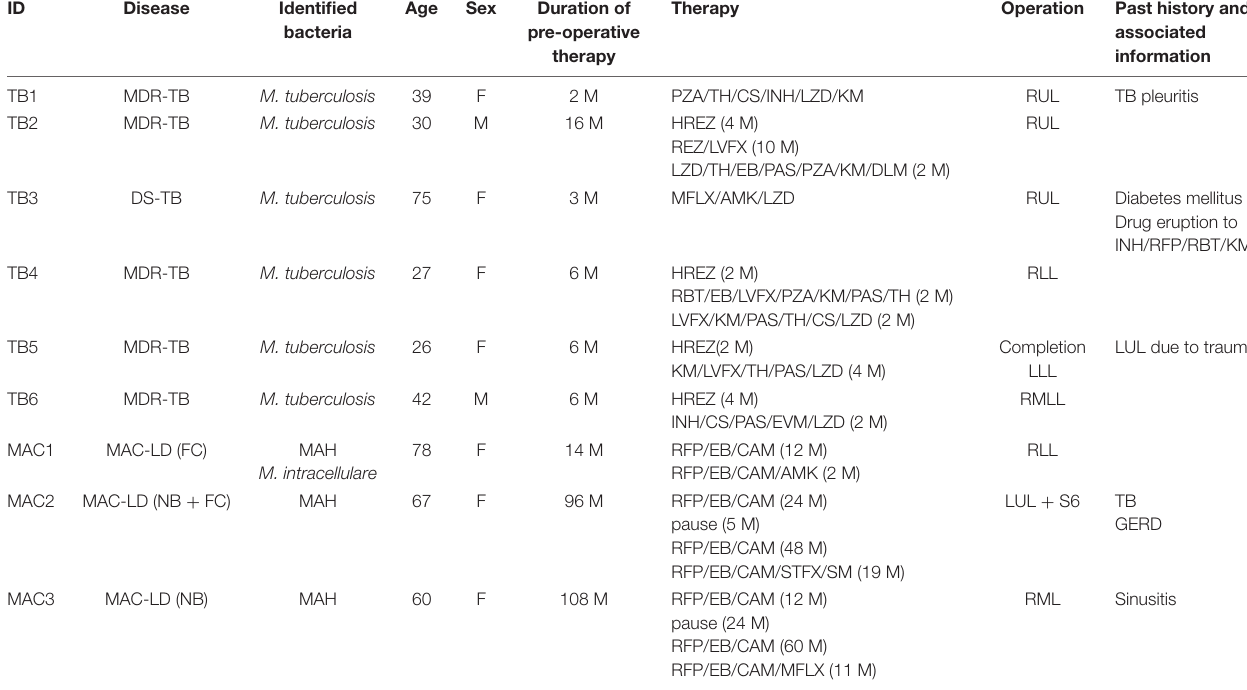
TABLE 1 | Patients’